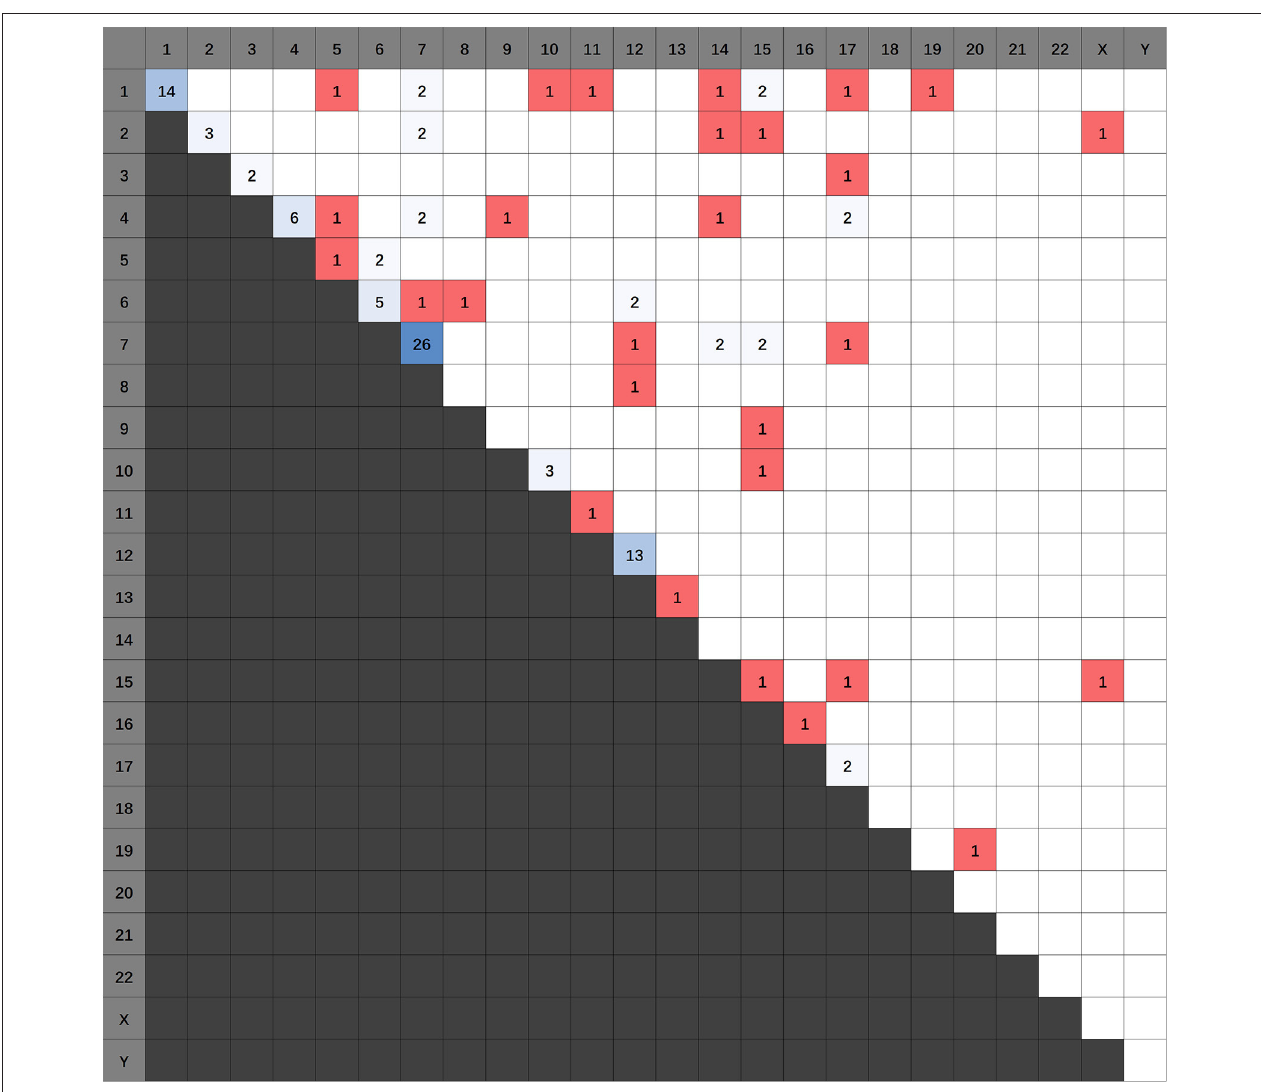
FIGURE 3 | Heatmap detailing the chromosomal locations of the fusions